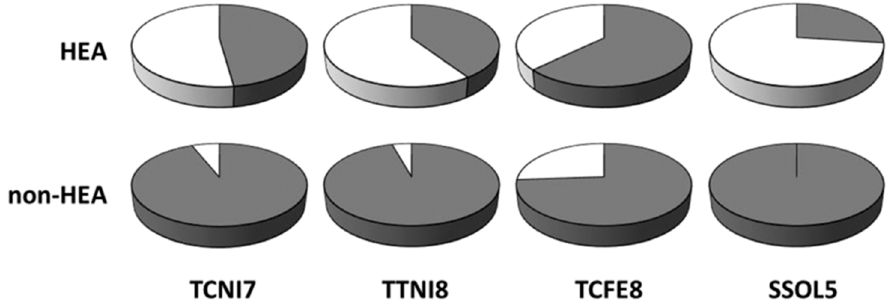
Figure 5. Capability of four different CALPHAD databases in predicting the formation of MPE alloys (HEA) and others (non-HEA). Dark sectors show success and light sectors represent the failure of the data bases (this figure is from Reference [41]).